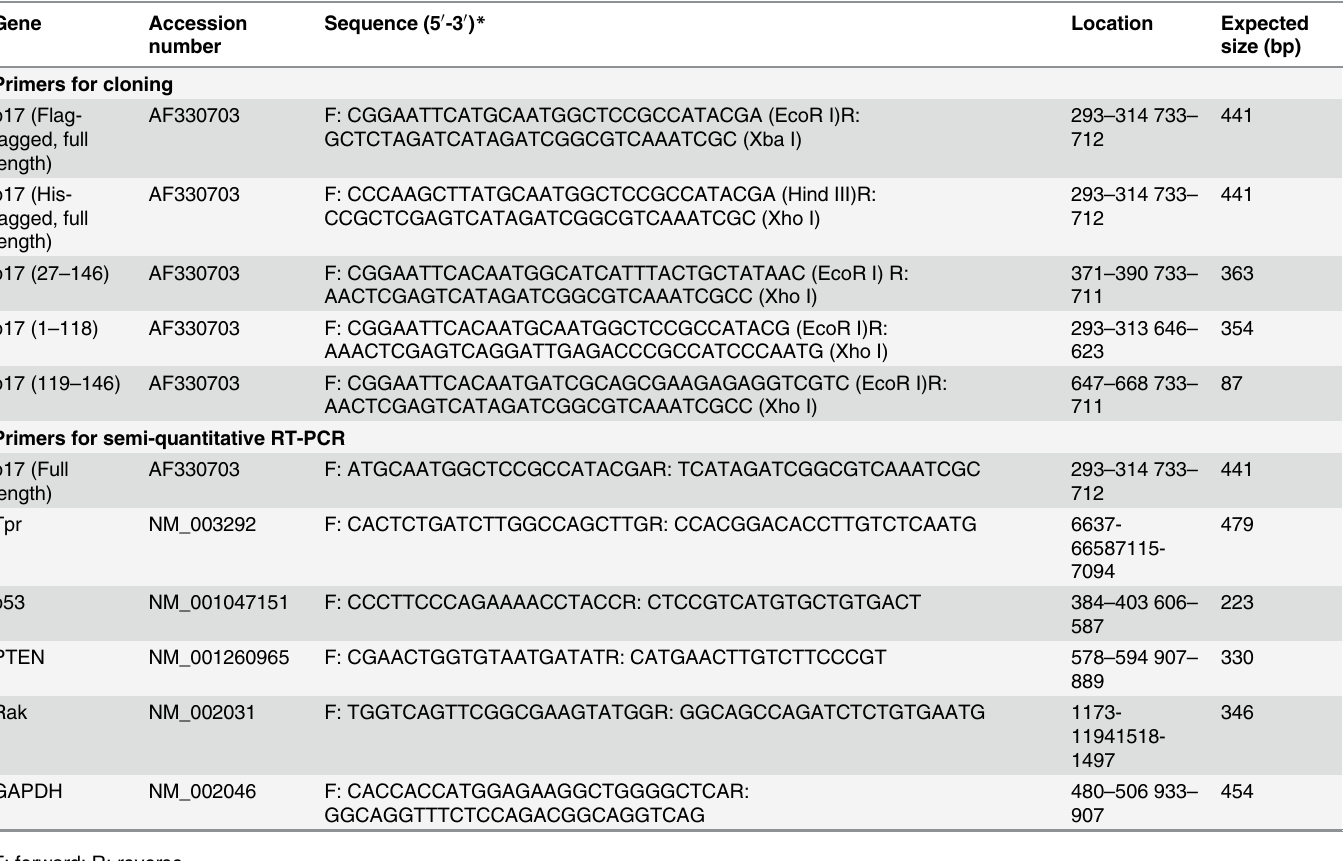
Table 1. Primers used in this study for amplification of the respective targeted